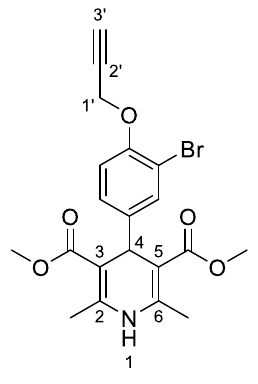
Figure 10. Chemical stucture of 3i .